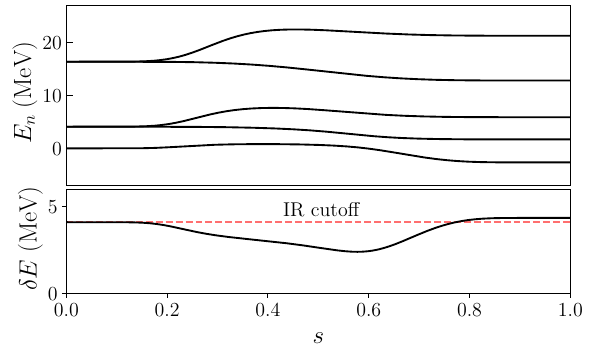
FIG. 7. (Top) The instantaneous spectrum during the adiabatic evolution for the first five states. At s = 0, the free-field Lapla- cian has a twofold degeneracy for periodic boundary conditions. The NN potential lifts the degeneracy afterwards. (Bottom) The energy gap between the first excited state and ground state as a function of evolution time s . The dashed red line is calculated from Eq. (25), yielding the infrared